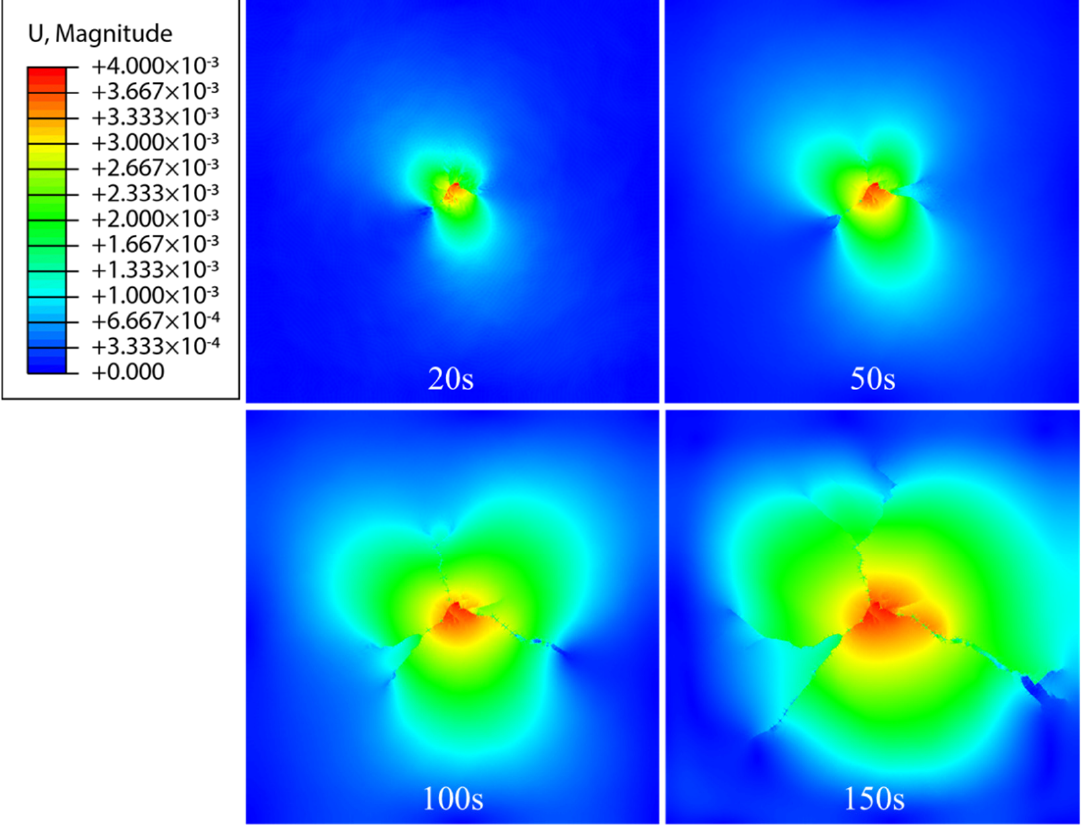
Figure 7. Displacement contour plot of the natural fracture network of group B at different moments under a stress difference of 0 MPa.